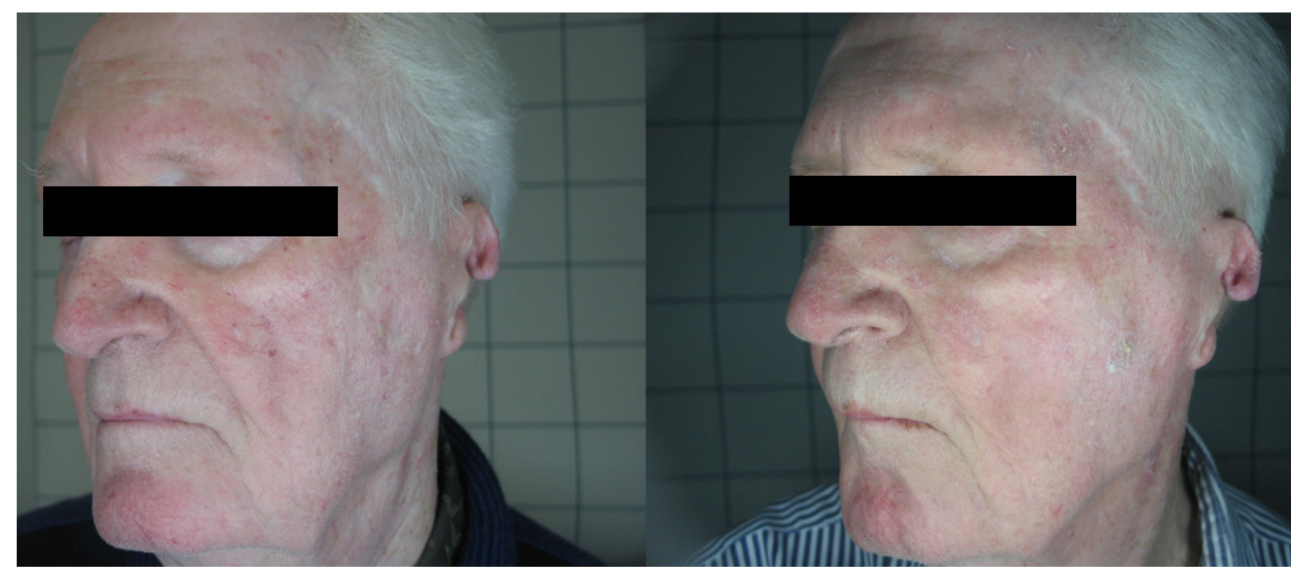
Figure 2. Patient n. 33 before (left) and 3 months after IPL treatment.